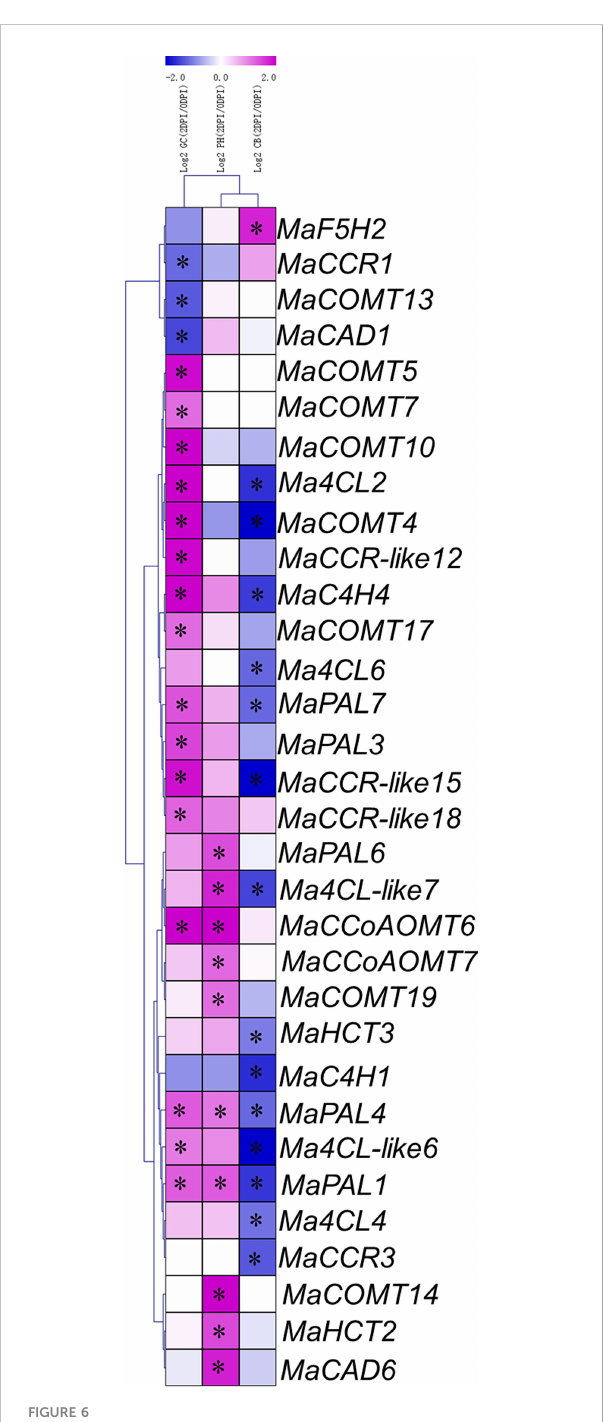
genes, respectively (Figure 8). The correlated TFs were in 68 different type TF classes, such as MYB, ERF, basic helix- loop-helix (bHLH), WRKY, C2H2, NAC, and LOB (Supplementary Table 8).